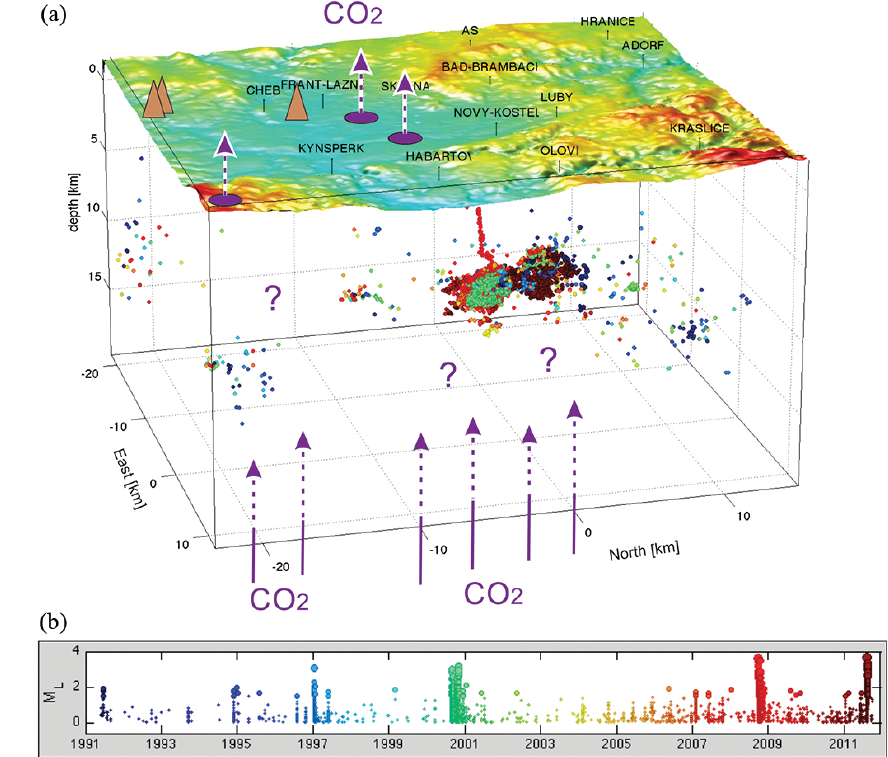
Figure 1. (a) Perspective 3-D view of the central earthquake swarm region in West Bohemia–Vogtland. Hypocenters are indicated by filled circles, the magnitudes and time of occurrence is plotted in (b) Topography is indicated as coloured map and ranges between 400 and 800m. Violet arrows sketch the possible CO 2 migration paths (di ff use or in channels). Mofettes indicated by violet ellipses; brown triangles mark known Quaternary volcanoes. See Fig. 3 for location in Central